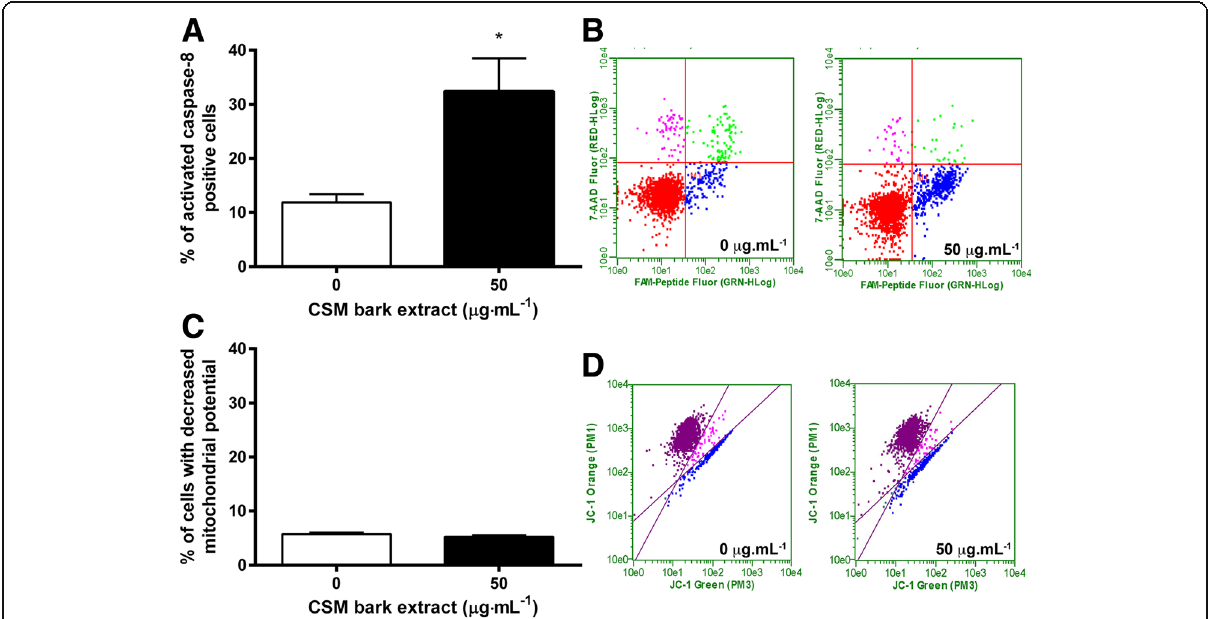
Fig. 5 Fraction of apoptotic cells with active caspase-8 ( a ) and with altered mitochondrial membrane potential ( c ) after 72 h treatment with 50 μ g·mL − 1 CSM bark extract. Panels b and d show representative dot plot of cells with active caspase-8 and altered mitochondrial membrane potential respectively. Active caspase-8 and mitochondrial membrane potential were evaluated by FCM as described in Methods. Each bar represents the mean ± SEM of five independent experiments. Data were analyzed by t-test for paired data. * p < 0.05 vs